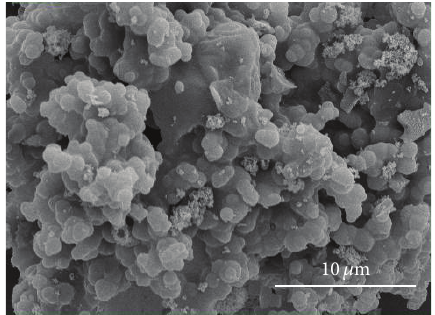
Figure 1: SEM image of synthesized PSTM-3T